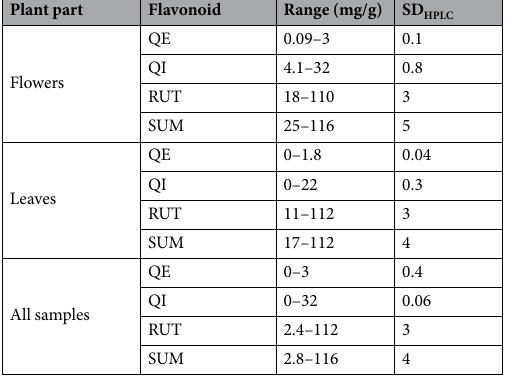
Table 2. Flavonoid concentration ranges and SD of the reference HPLC data for quercetin (QE), quercitrin (QI), rutin (RUT) and the sum of the flavonoids (SUM).